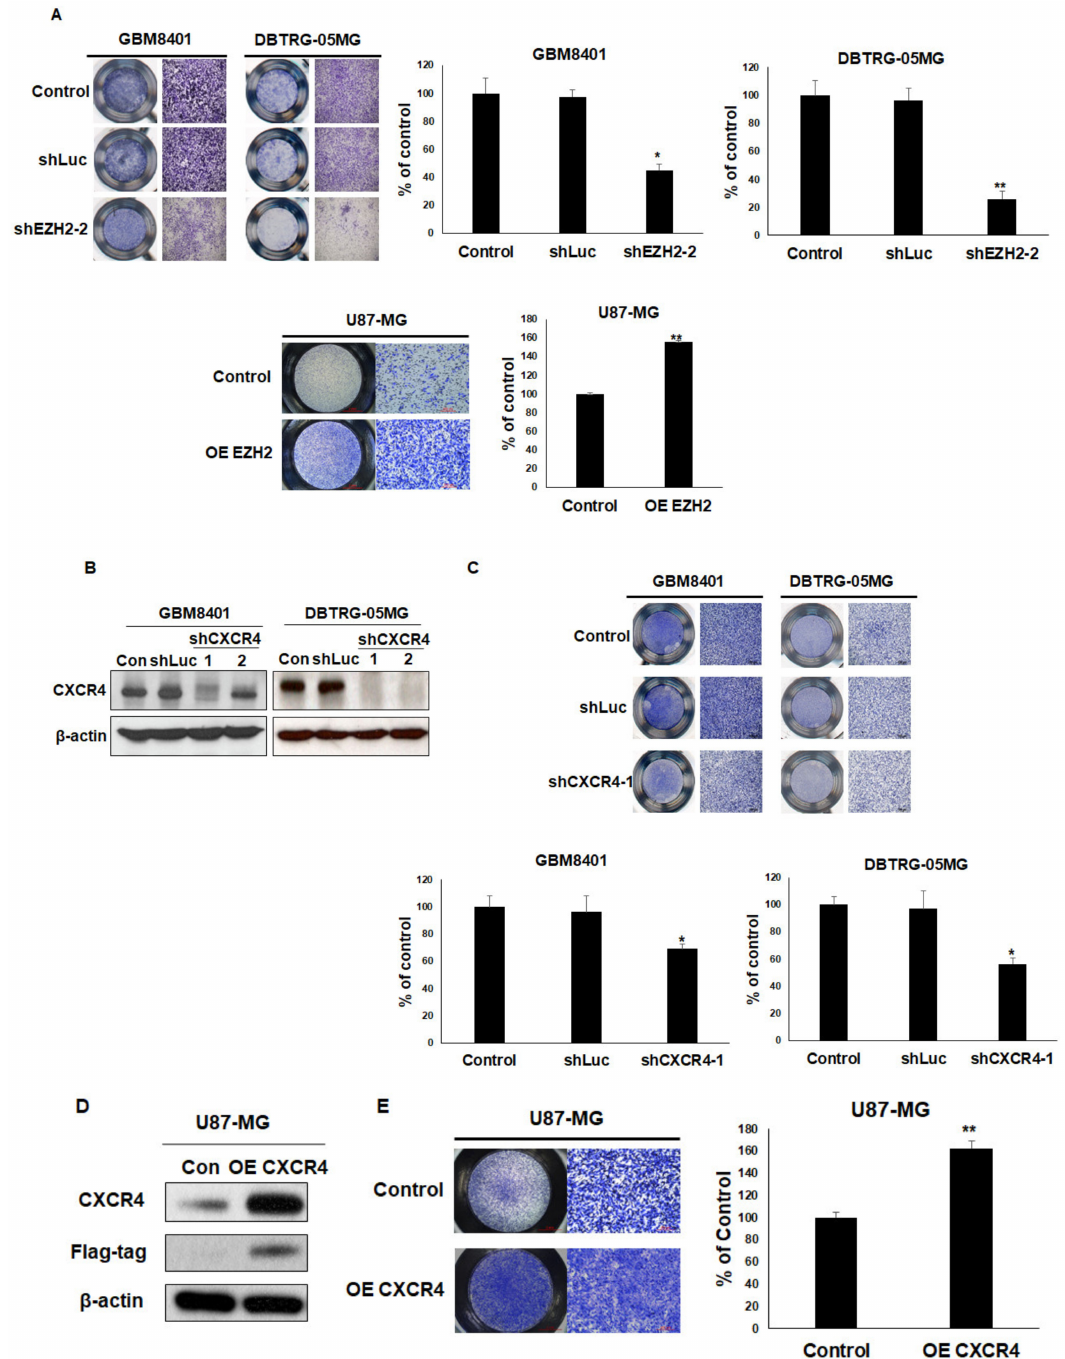
Figure 5. The e ff ects of EZH2 and CXCR4 knockdown or overexpression on GBM cell migration. ( A ) Transwell migration assays were used to evaluate the e ff ects of shEZH2-2 or Myc-EZH2 overexpression on the migration of GBM cells. Representative photographs of transwell assays. The bound crystal violet staining was released with 33% glacial acetic acid and quantified by absorbance measurements (OD570) ( B ) Western blot analysis of CXCR4 protein in CXCR4 knockdown cells. ( C ) Transwell migration assays and quantification of these assays were used to assess the e ff ects of shCXCR4-1 and shLuc (as a control) on GBM cell migration. ( D ) Western blot analysis of CXCR4 protein in Flag-CXCR4 overexpression (OE) U87-MG cells. ( E ) Transwell migration assays and quantification of these assays were used to assess the e ff ects of Flag-CXCR4 on U87-MG migration. Mean ± SD, n = 3. * p < 0.05; ** p < 0.01. The raw data of Western blots is shown in Figure